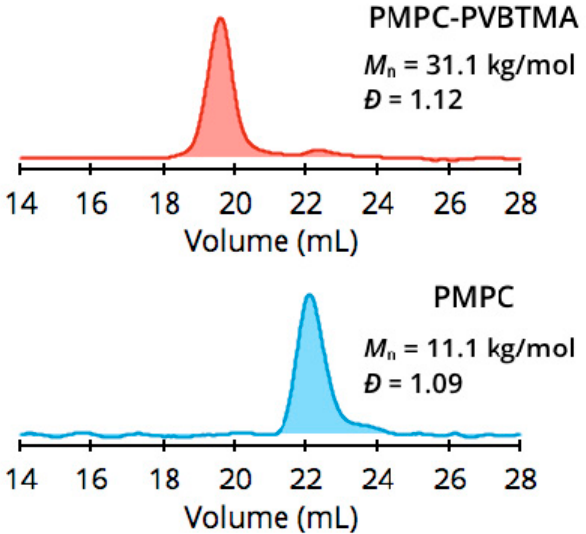
Figure 4. Representative size-exclusion chromatography (SEC) refractive index traces of poly(2-methacryloyloxyethyl phosphorylcholine) 10K (PMPC 10K , blue curve, bottom) and poly(2-methacryloyloxyethyl phosphorylcholine) 10K - block -poly((vinylbenzyl)trimethylammonium chloride) 97 (PMPC 10K - b -PVBTMA 97 , red curve, top).